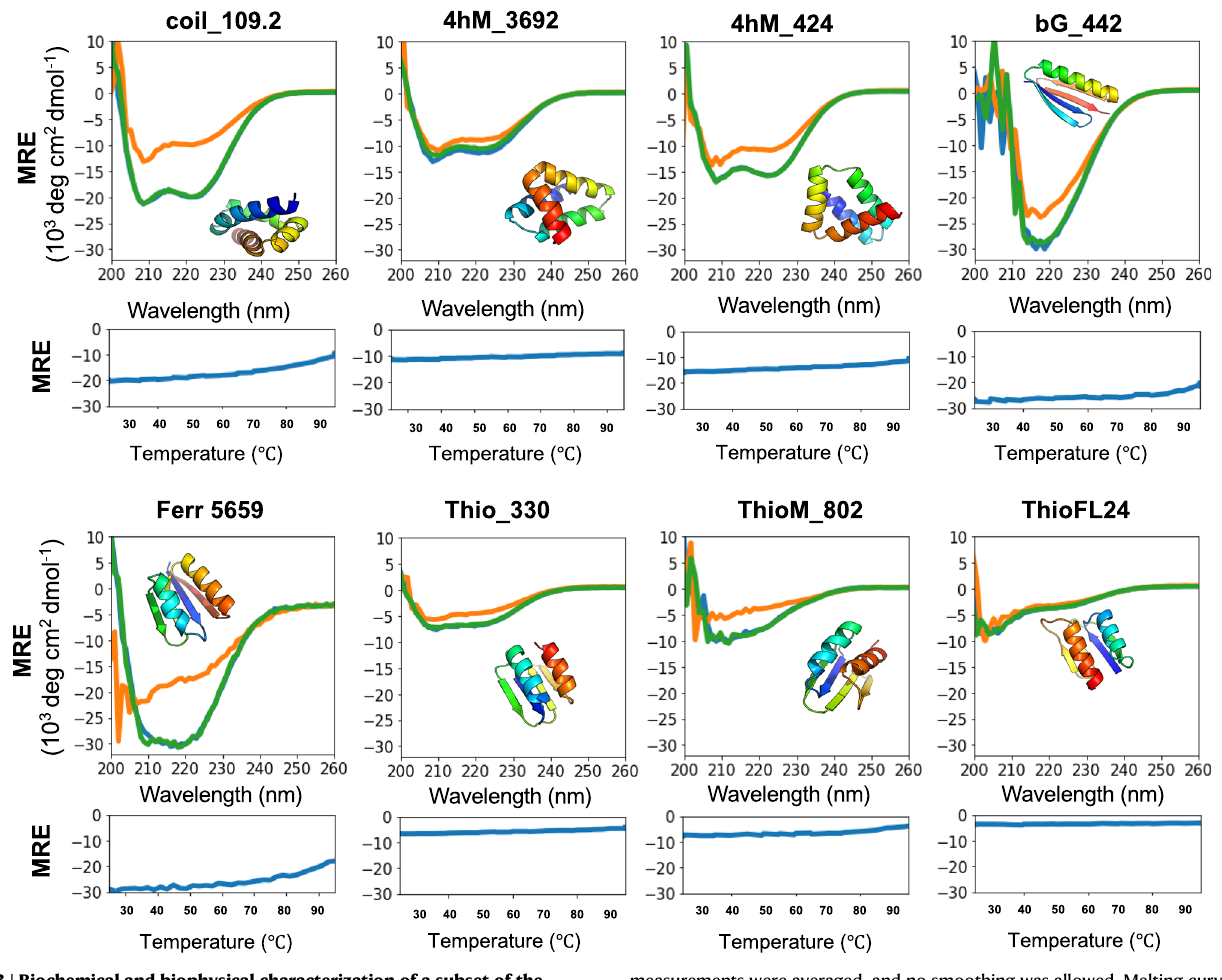
measurements were averaged, and no smoothing was allowed. Melting curves show the change of molar residue ellipticity (MRE) at 220nm at increasing tem- peratures. Source data is provided as Source Data